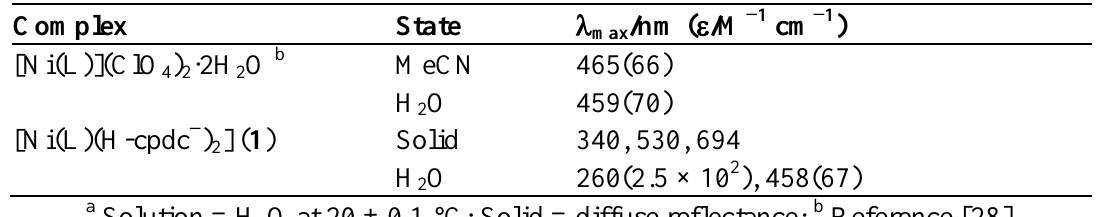
] ( 1 ) by the diffuse 2